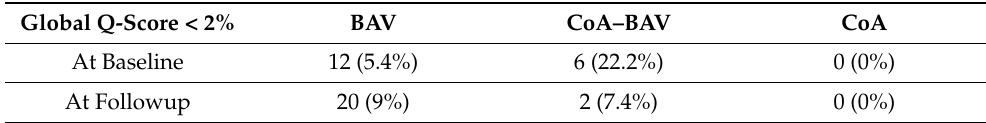
Figure 2. Prevalence of aortic dilation in the 2 groups of patients at baseline and followup; p < 0.0001 for both comparisons. BAV = bicuspid aortic valve; CoA = aortic coarctation. Table 4. Prevalence of aortic dilation considering global Q-score at baseline and followup. BAV = bicuspid aortic valve; CoA = aortic